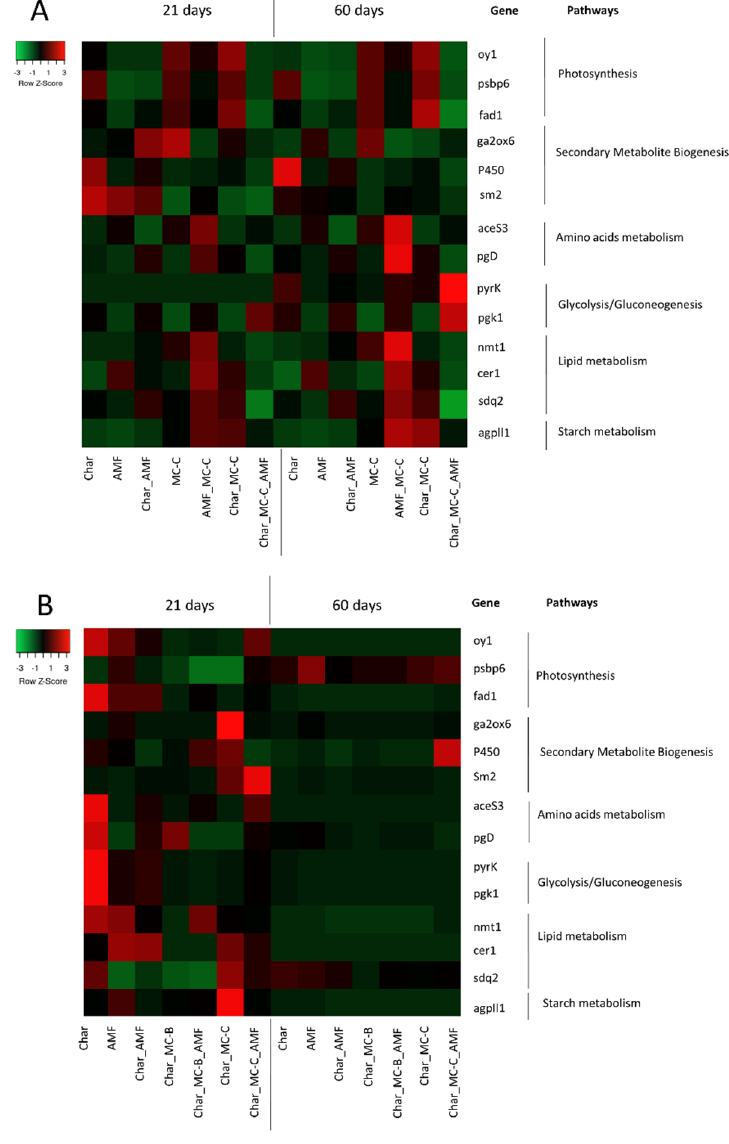
Figure 4. Heatmap showing the fold-change values in the 14 target genes analyzed in leaves at 21 and 60 DAS in response to the eight different treatments in wheat ( A ) and maize ( B ). For each gene, the corresponding pathway is indicated. Each row represents a gene and each column represents a treatment. Red and green correspond, respectively, to low and high expression levels. All values were normalized with respect to the control, which is therefore not shown.